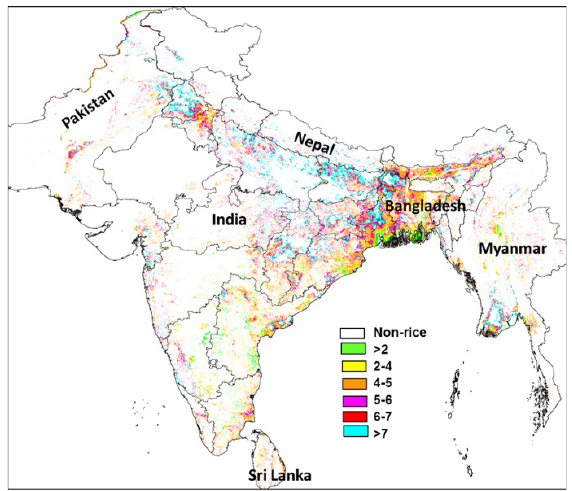
Fig 7: Comparison of estimated rice yield using SCATSAT-1 backscatter and reported rice yield at national level yield in six South Asian